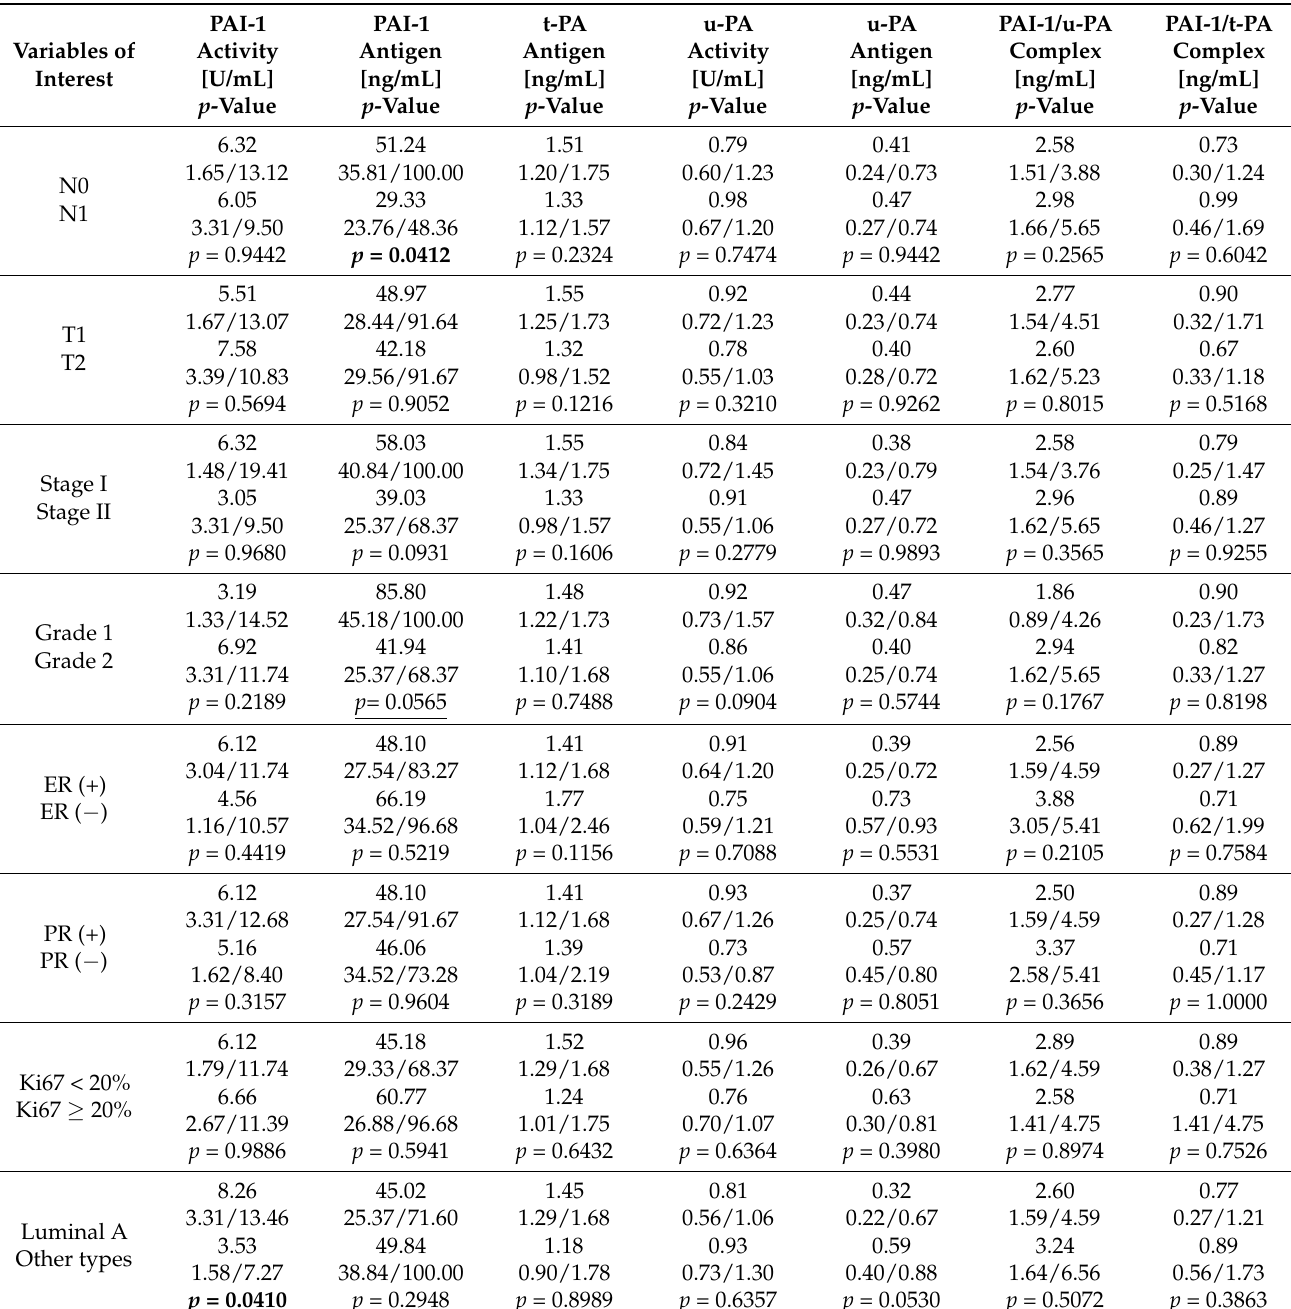
Table 3. The fibrinolytic profile analysis with respect to clinicopathological